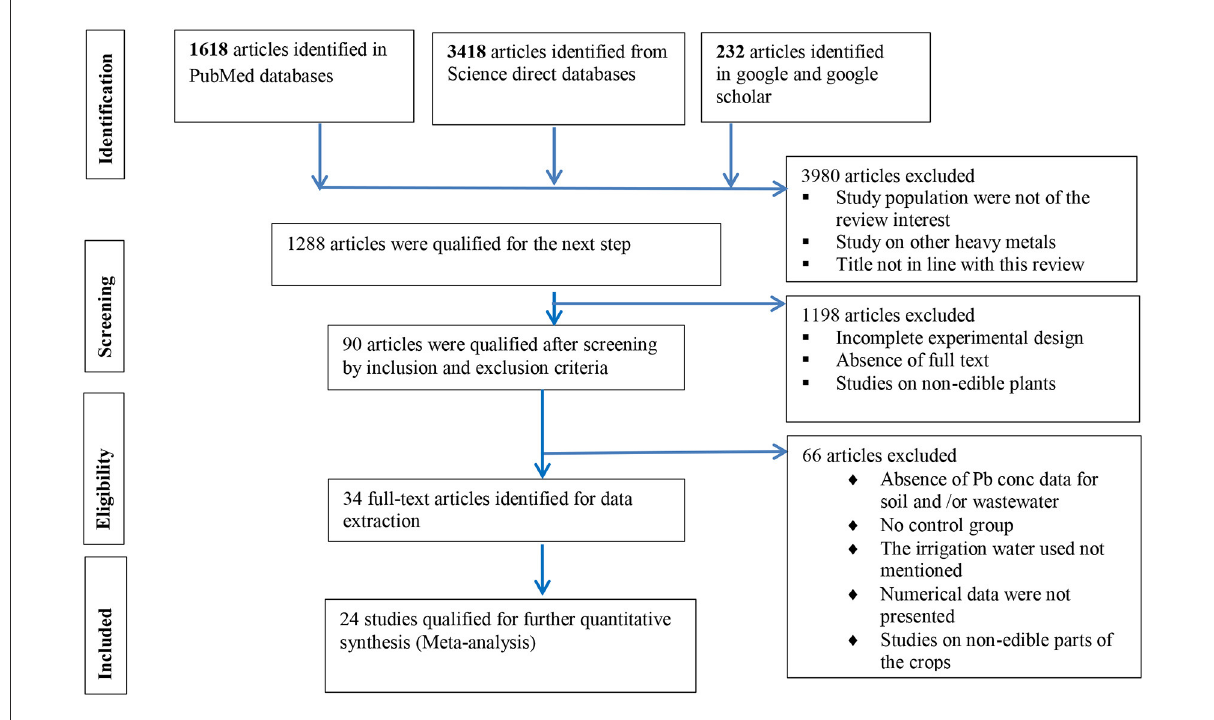
FIGURE1 A PRISMA flowchart outlining the study selection